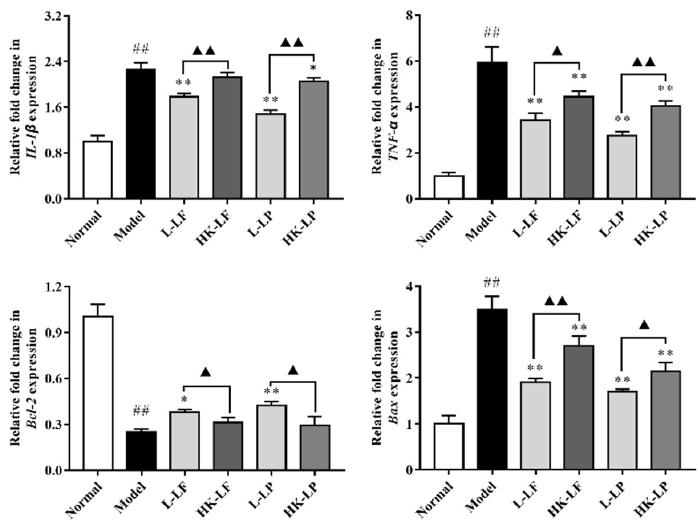
Figure 7. Related gene expression levels in liver injury. ## p < 0.01 compared with the normal group, * p < 0.05, ** p < 0.01 compared with the model group, ▲ p < 0.05 and ▲▲ p < 0.01.